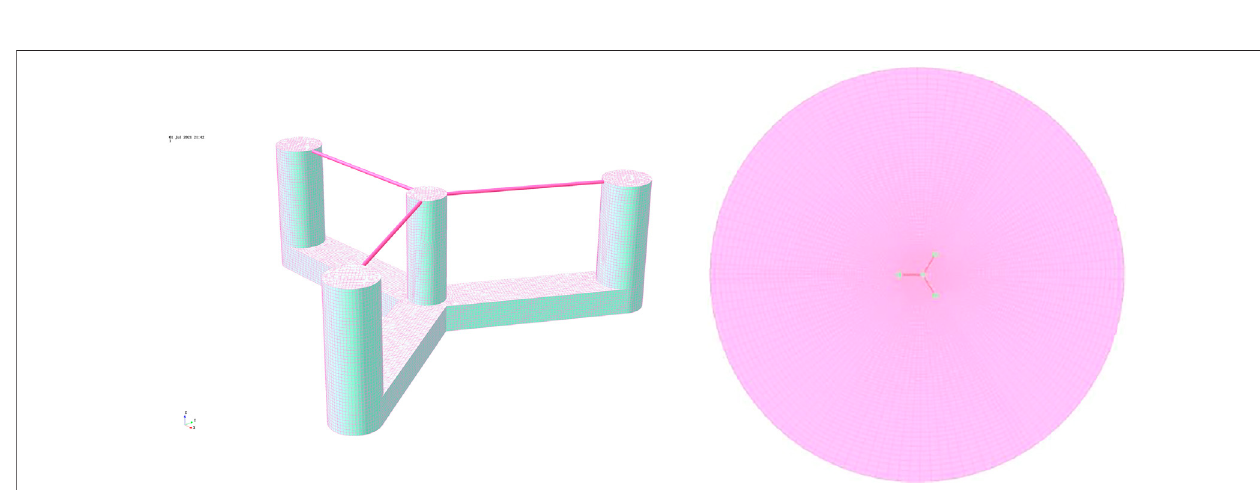
FIGURE 3 | Mesh models of hydrodynamic analysis. (A) Selected mesh models of the semi-submersible platform. (B) Free surface mesh for QTF calculation.